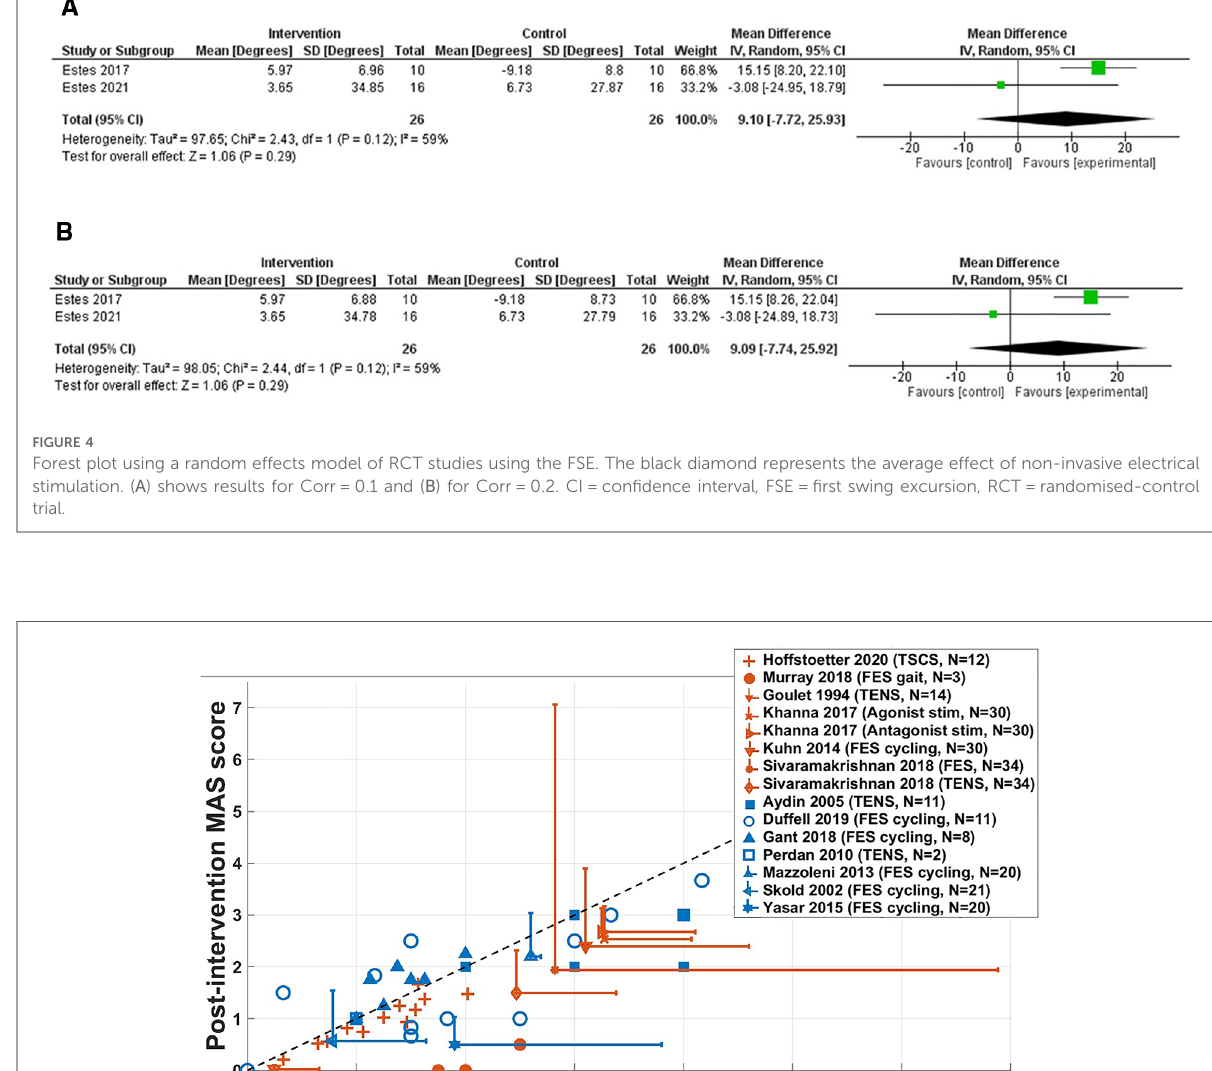
show large standard deviations, indicating a large variance across results for individual participants, where some may not have bene fi tted from the intervention. For participants who took part in the study by Gant et al. (52), MAS scores of all participants were either increased or unchanged following 19 weeks of FES cycling. for individual participants were available and reported as R 2n